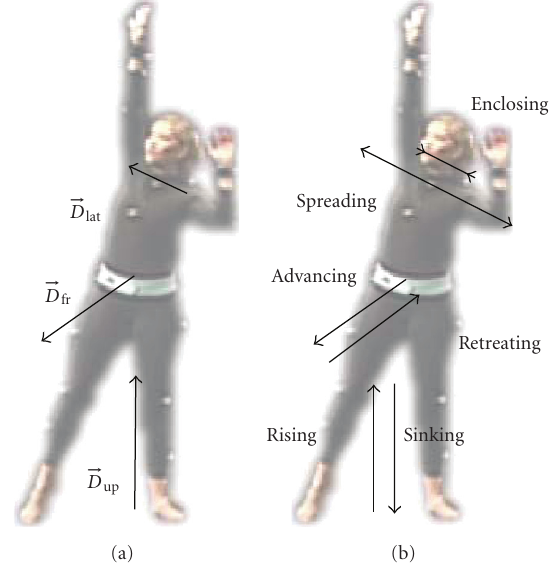
Figure 6: Directional vectors used in feature calculation, and Shape qualities corresponding to each vector. Spreading / enclosing (cid:2) is expected to occur along the lateral D lat ) direction, advanc- (cid:2) ing / retreating along the front D fr ) direction, and rising / sinking over (cid:2) the up D up )